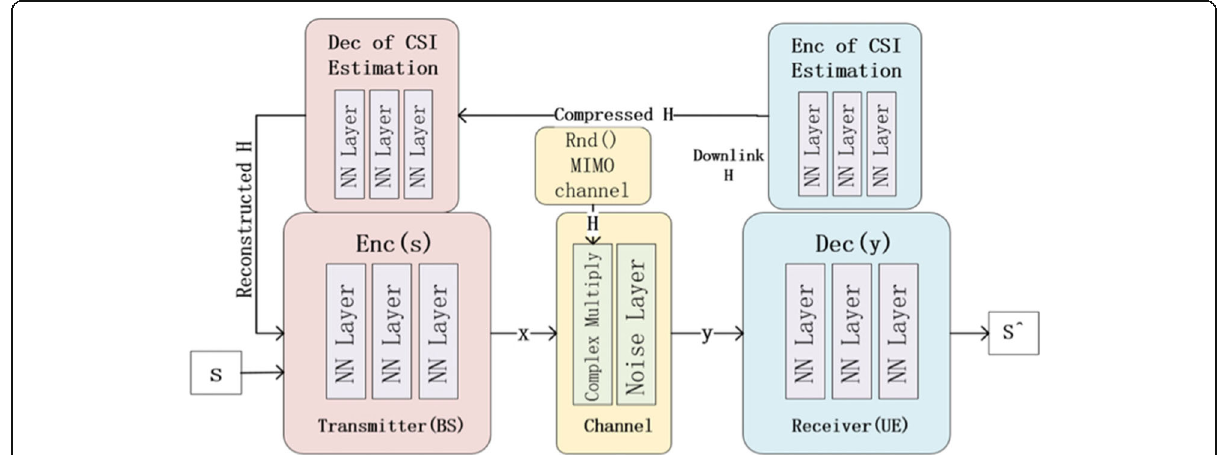
Fig. 4 The structure of autoencoder-based MIMO systems with downlink CSI